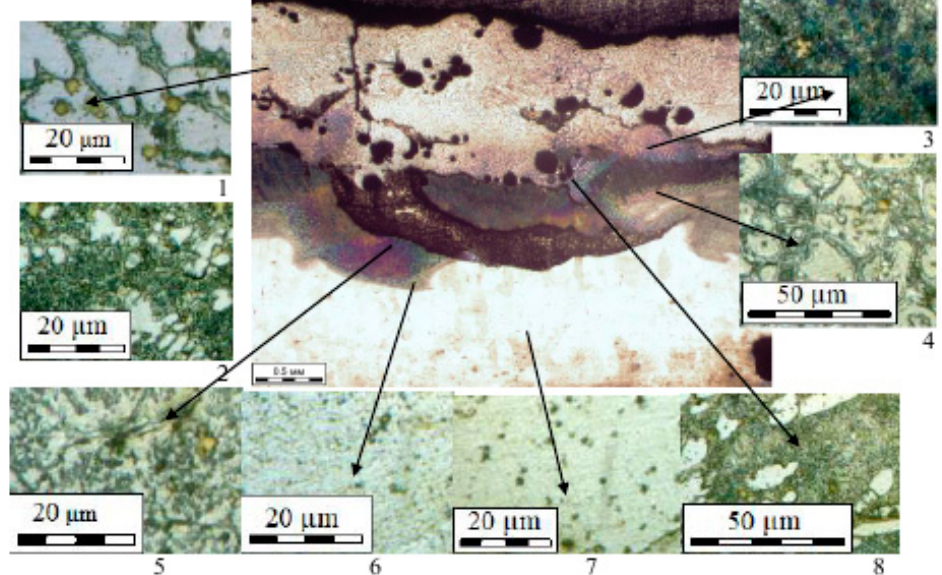
Figure 2. Optical micrographs showing the SEM microstructures of the DED of a Ti-Fe multilayer sample: central image has a magnitude of 25; detailed pictures have magnitudes of